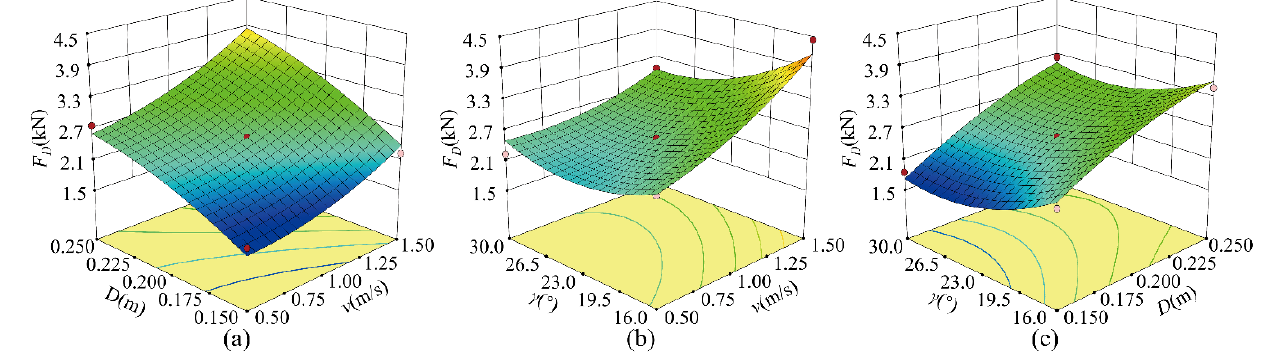
Figure 10. Response surfaces of YS’s simulated draught force under the influence of different factors. ( a ) v and D , γ = 23°; ( b ) v and γ , D = 0.20 m; ( c ) D and γ , v = 1 m/s.